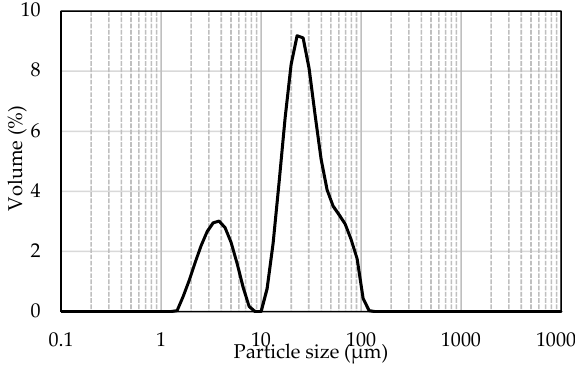
Figure 2. Particle size distribution of fly ash.